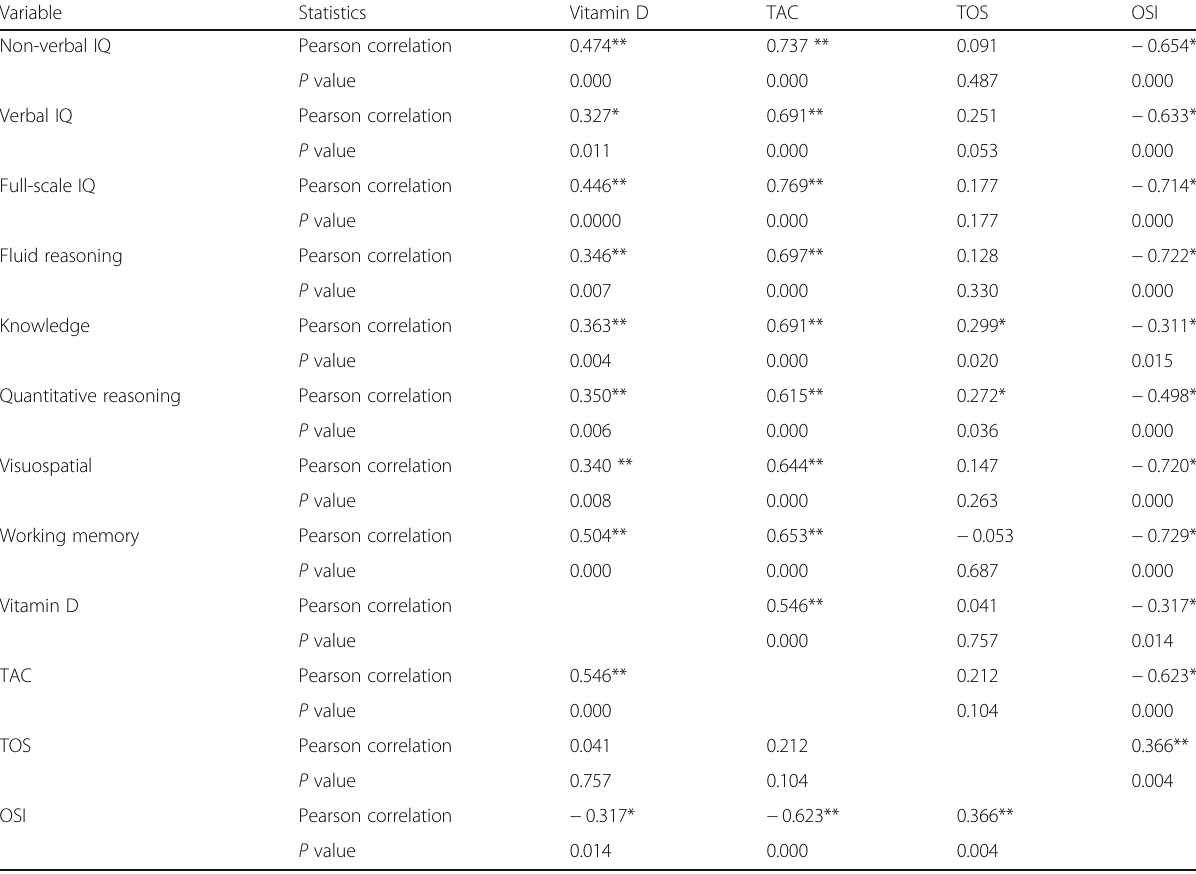
Table 4 Correlation between cognitive function parameters, Vitamin D level, and oxidative stress parameters in all studied children